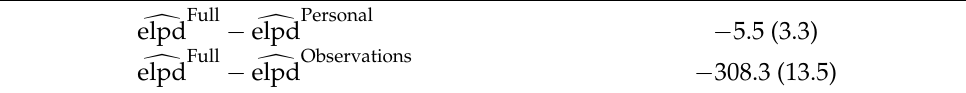
Table 2. Comparison of fitted models. The rows show the difference in (cid:100) elpd, with estimated standard error in brackets, between the Full model and remaining models ( Personal and Observations ).